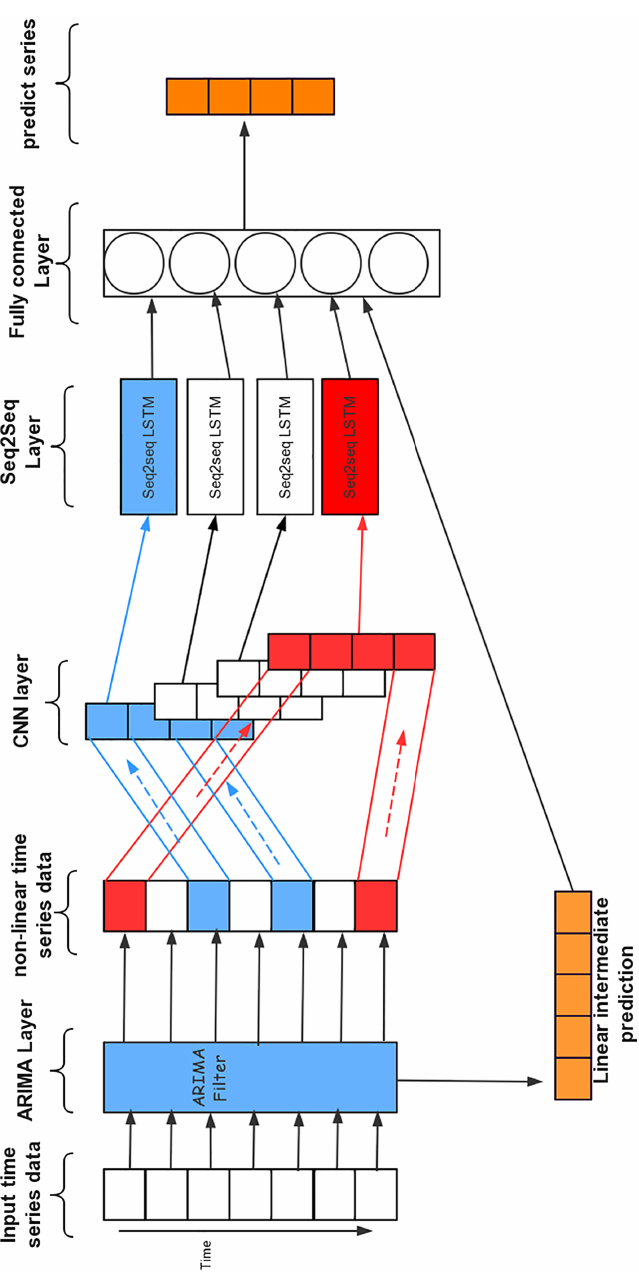
Figure 2. An overview of RCCSNet NN, which has the ARIMA, CNN, Seq2Seq LSTM and FC